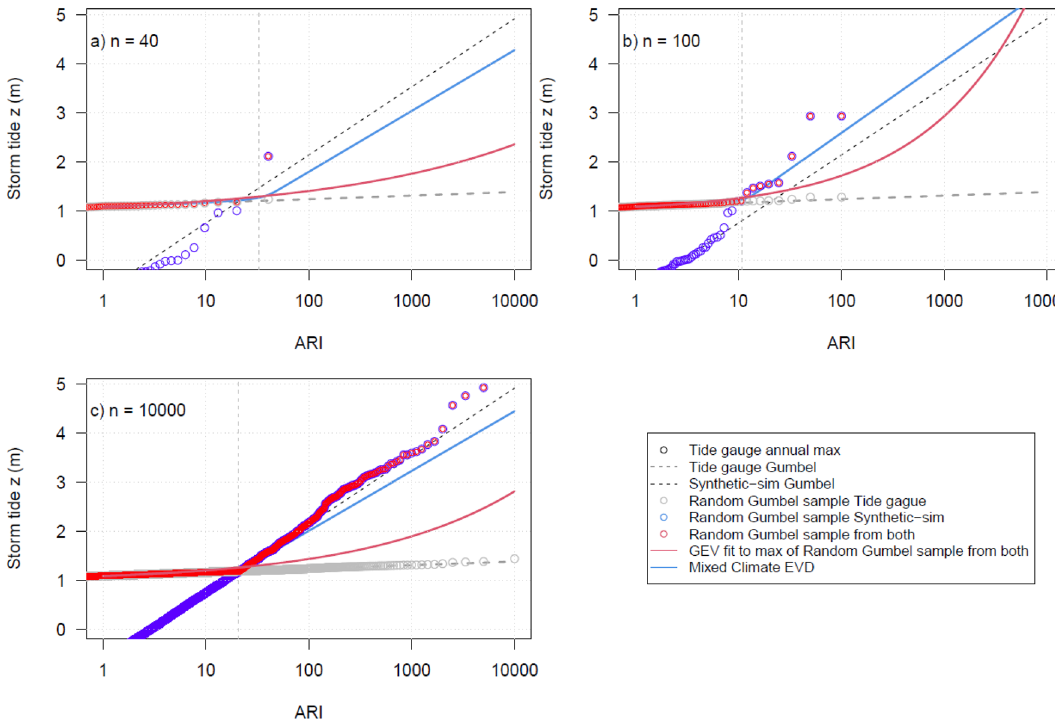
Figure 4. Random sampling of the mixed-climate EVDs for record length (n) equals 40 years (top left), 100 years (top right) and 10,000 years (bottom left) for Lautoka, Fiji.